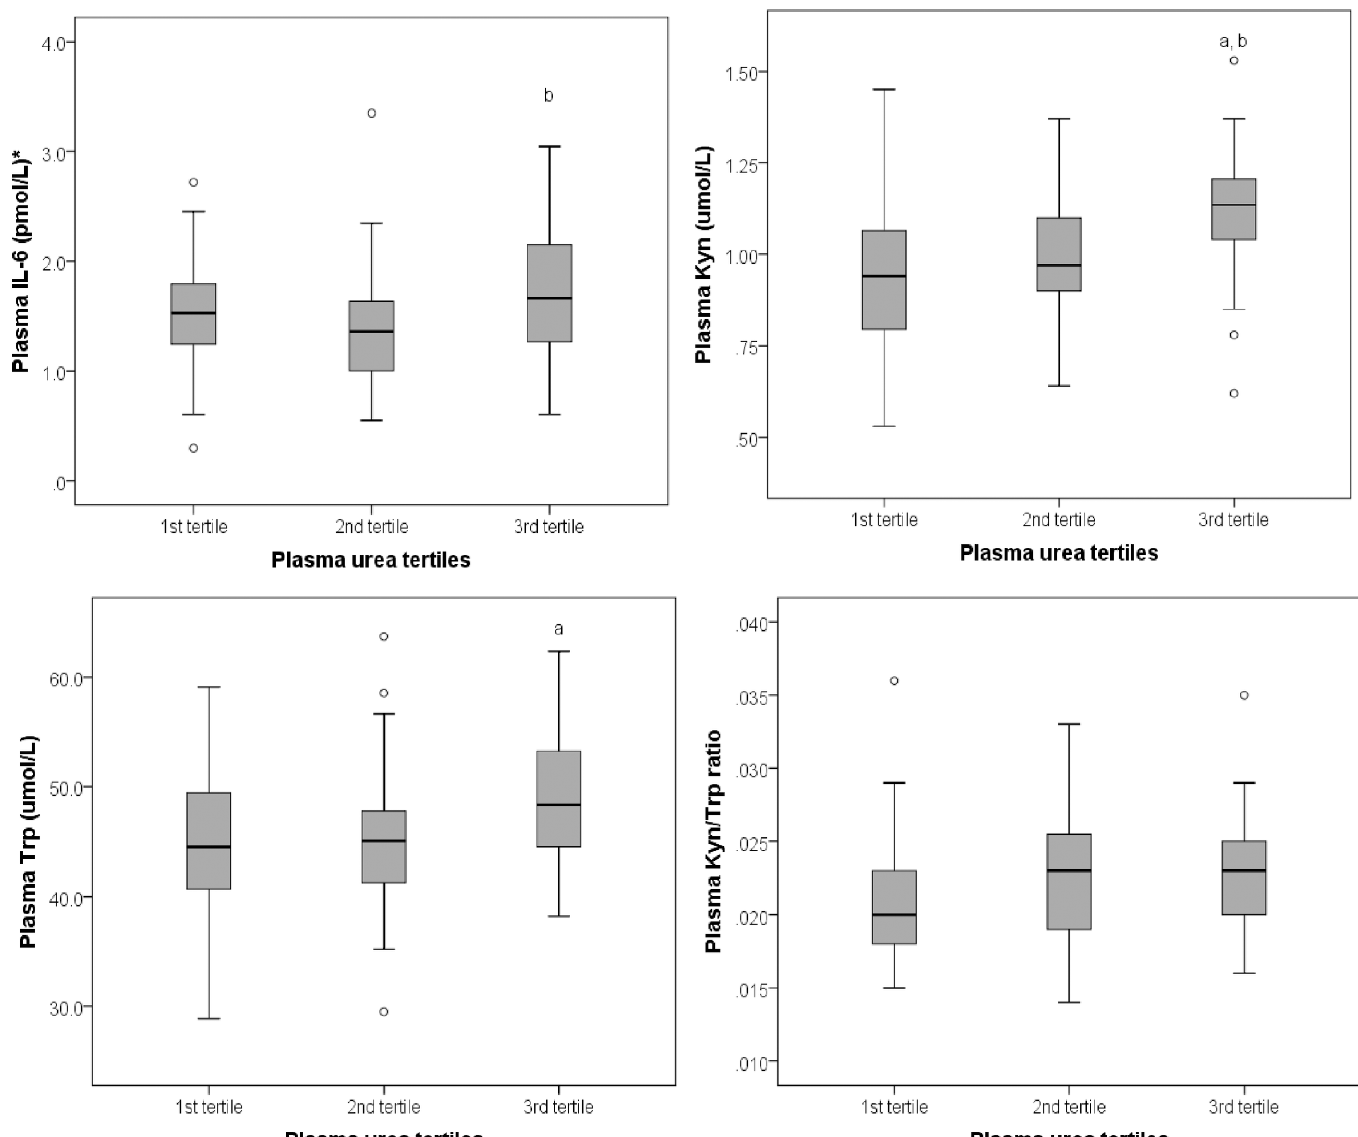
Fig 3. Mean plasma levels of interleukin-6 (IL-6), Kynurenine (Kyn), Tryptophan (Trp) and Kyn/Trp ratio across tertiles of plasma urea. (cid:3) Data represented as square root IL-6. a significantly different compared to 1 st tertile, b significantly different compared to the 2 nd tertile.